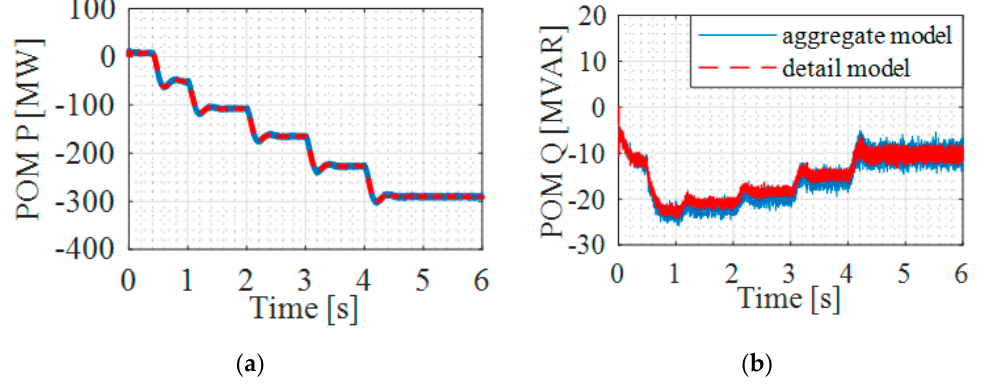
Figure 12. Active and reactive power at the POM for Case 2 using aggregated and detailed models: ( a ) Active power, ( b ) Reactive Power.